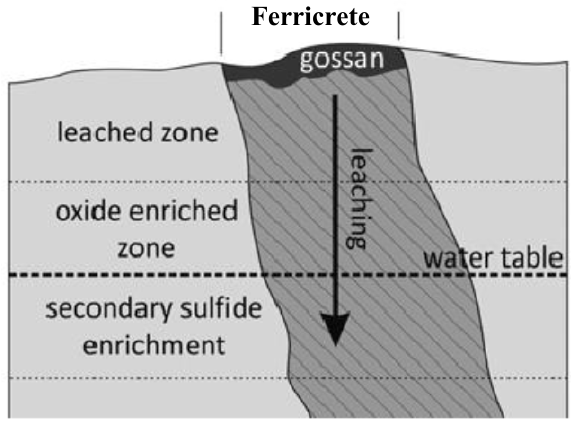
Figure 1. Illustration of a simplified gossan structure adapted from [3].